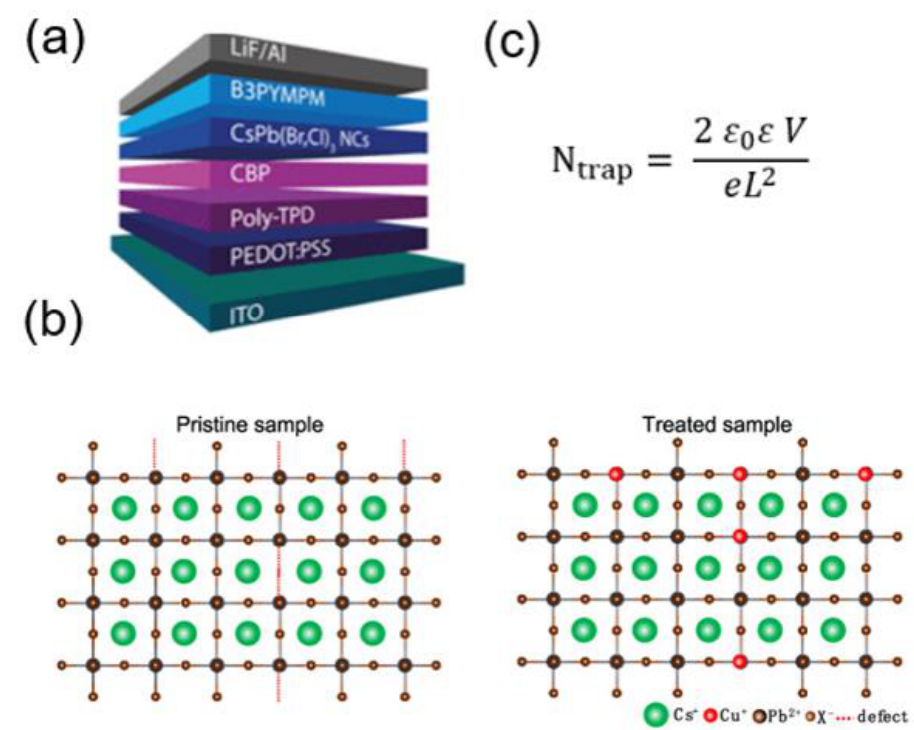
Figure 4. ( a ) Schematic drawing of the LED stack [51]. Copyright 2019 American Chemical Society. (b ) Mn 2+ , Cd 2+ , Ni 2+ , Cu 2+, and Zn 2+ , and other ionic substitutions to replace Pb sites [4]. Copyright